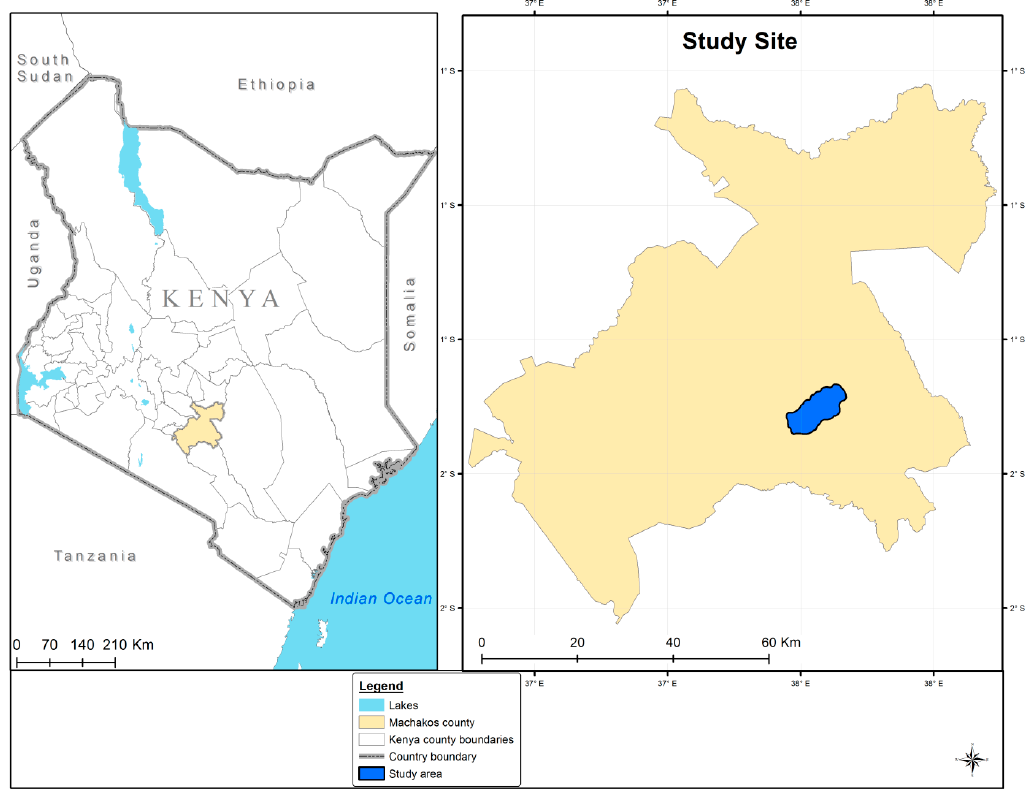
Figure 1. Locations of the study area in Machakos County, Kenya, with the dark blue polygon showing the study area. Grey lines illustrate sub-county boundaries.